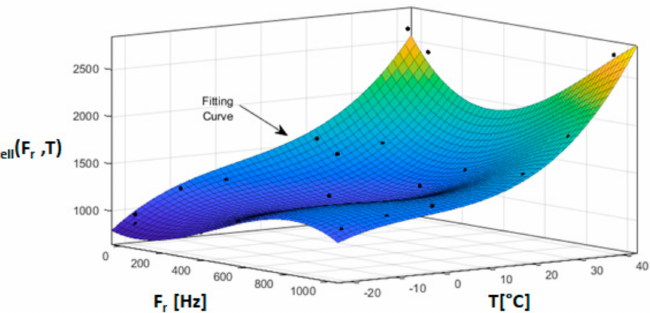
Figure 4. Sc capacitance as function of temperature and DC-current ripples frequency F r in [Hz] for 500